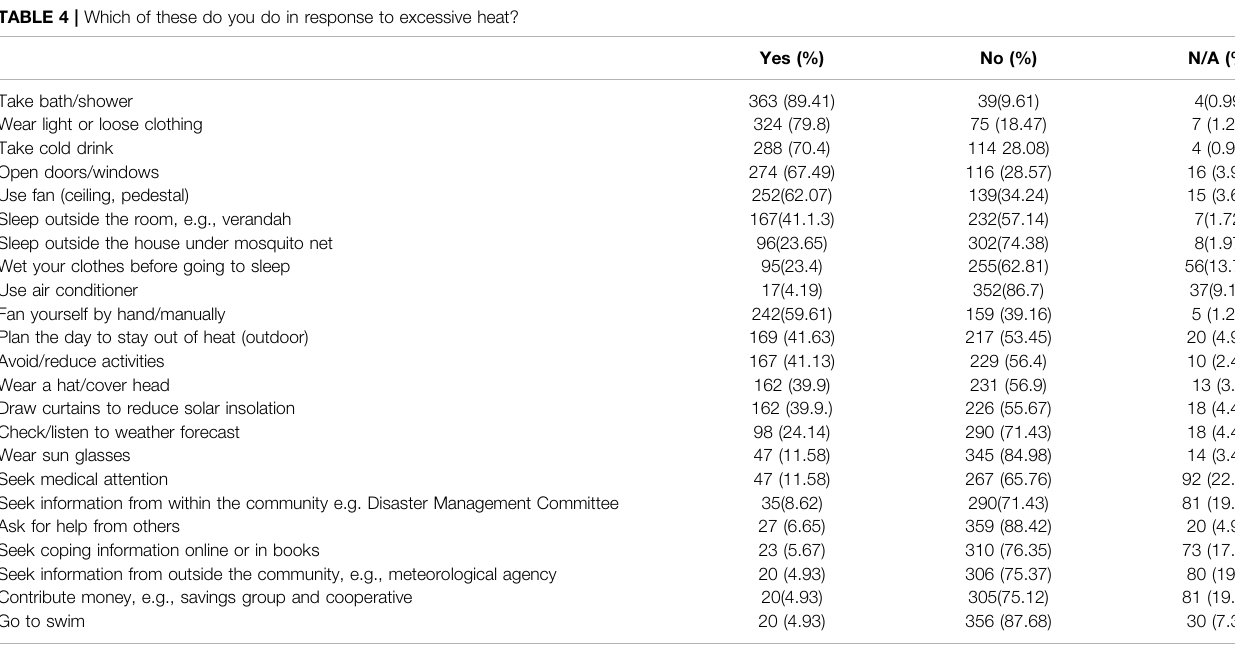
TABLE 4 | Which of these do you do in response to excessive heat?